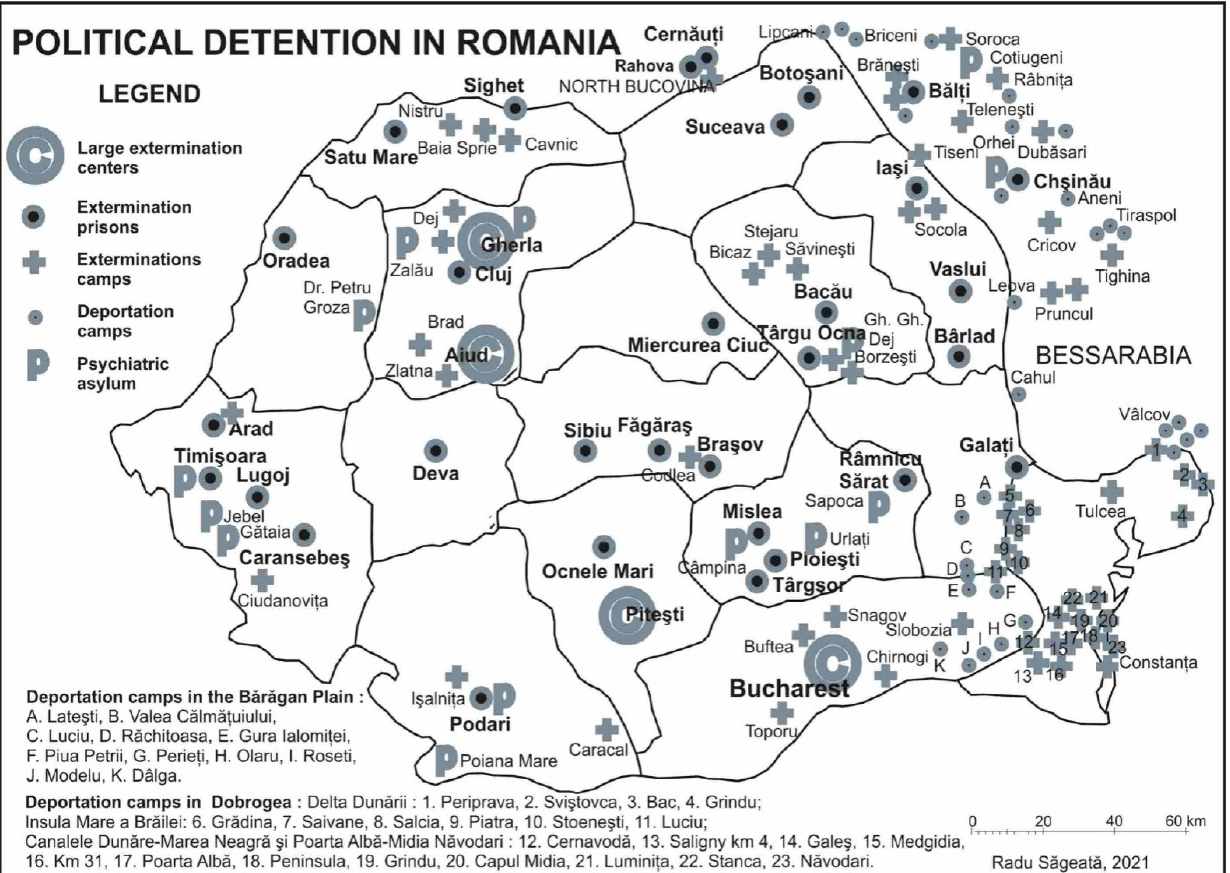
Figure 1. Political detention in Romania. Map designed by Radu S ă geat ă , 2021, based on data sources from [10,12]. The withdrawal of the Soviet armies from Romania (1958) together with the eradi- cation of the last outbreaks of anti-communist armed counterinsurgency (1960) and the transition from Soviet communism to its nationalist counterpart, created the premises for the release of political prisoners between 1962 and 1964, who, despite everything, continued to be socially marginalized and kept under the strict supervision of the